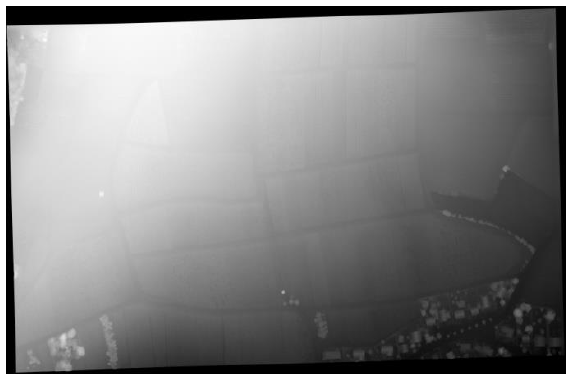
Figure 3. This screenshot shows the DSM of test-area 2 cre- ated from the complete camera-setup using all five views of the OIS-L.